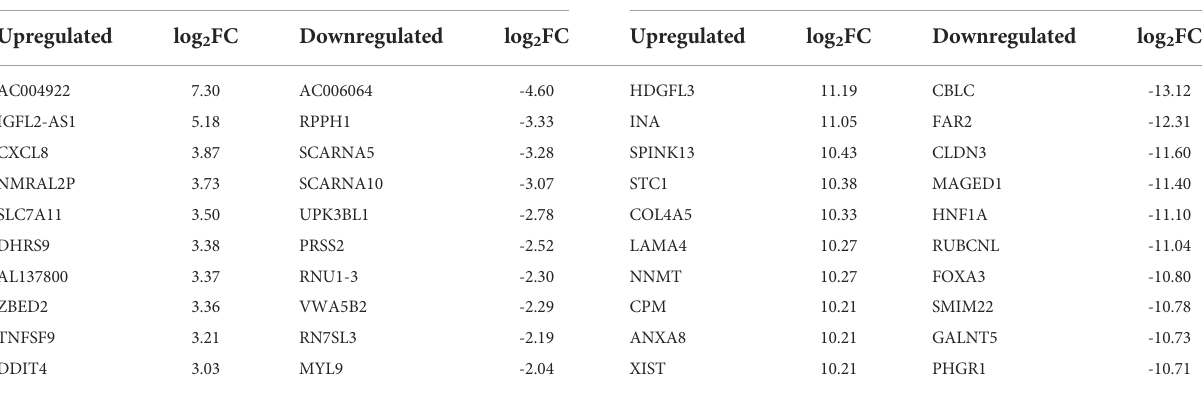
TABLE 2 The top 20 differentially expressed genes in DOK and SCC-9 cells compared with HOEC cells. DOK